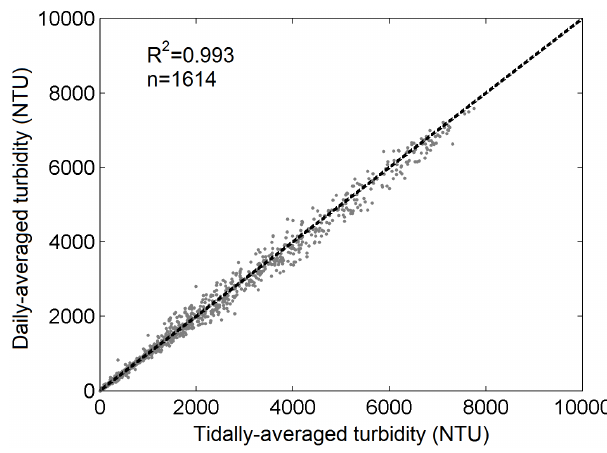
Figure 2. Comparison of tidally averaged turbidity and daily aver- aged turbidity for Bordeaux station showing the correlation coeffi- cient ( R 2